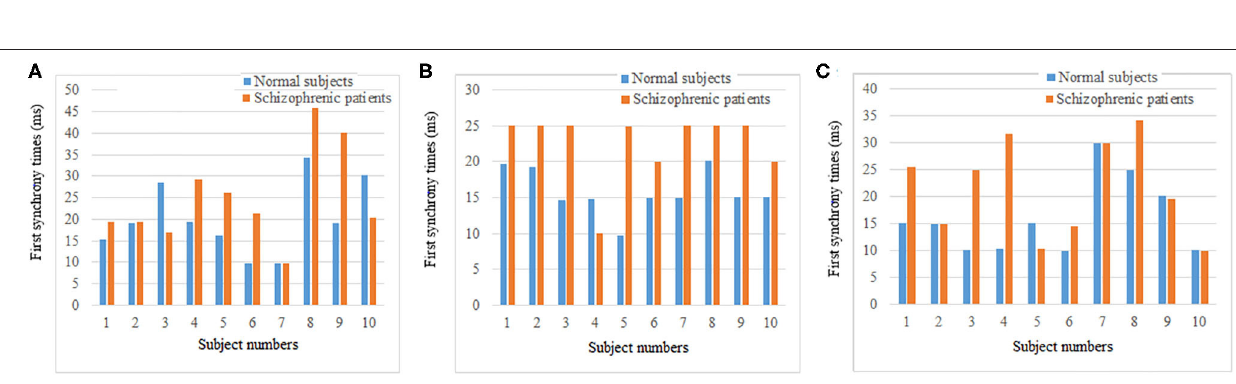
Frontiers in Psychiatry |